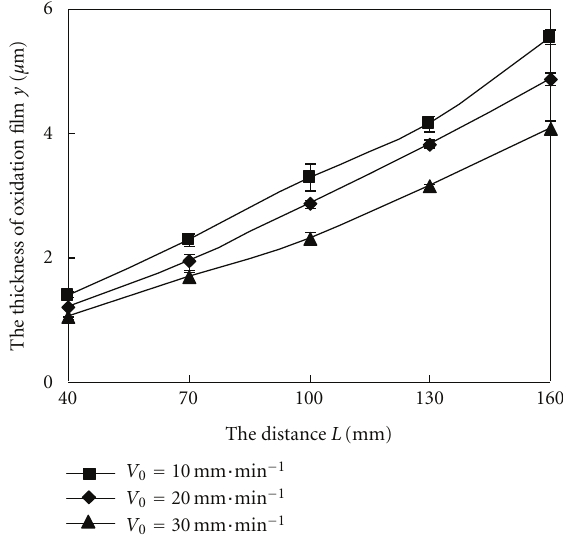
Figure 4: Thickness distribution of oxidation film on tapered pipe surface for di ff erent the distance between heat and cold sources.